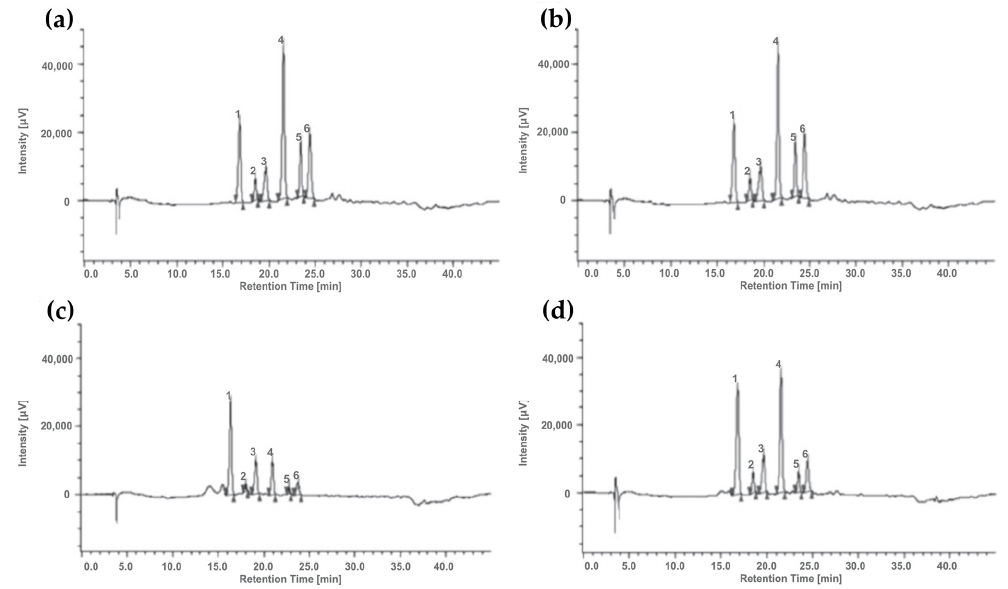
Figure 6. Chromatographic profiles of anthocyanins in ( a ) Reduno, ( b ) Pop, ( c ) Polenta, and ( d ) Sugary samples: (1) cyanidin-3- O -glucoside; (2) pelargonidin-3- O -glucoside; (3) peonidin-3- O -glucoside; (4) cyanidin-3- O -(6 ′′ -malonil-glucoside); (5) pelargonidin-3- O -(6 ′′ -malonil-glucoside); (6) peonidin-3- O -(6 ′′ -malonil-glucoside).